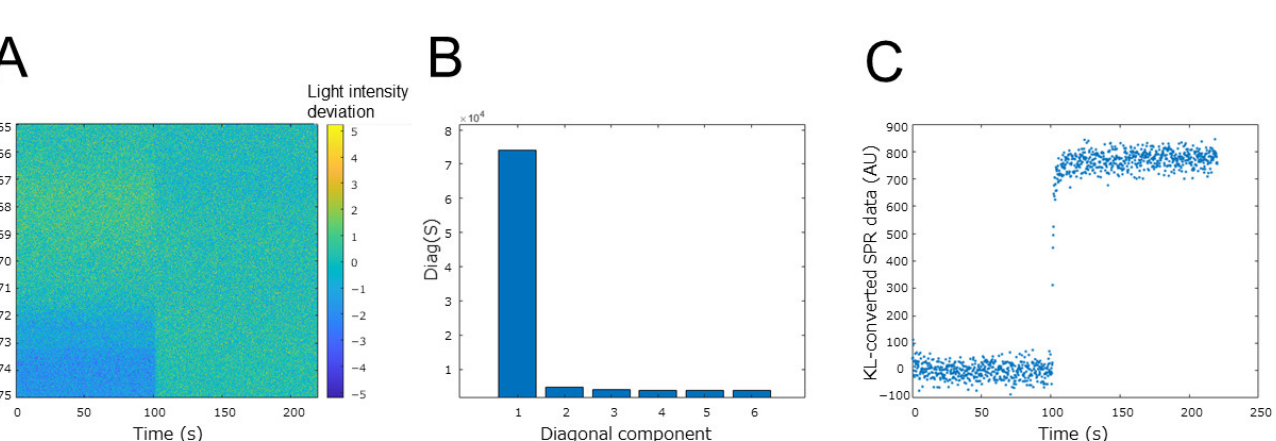
Figure 6. Change in KL-converted SPR curve data when sweeping the potential. ( A ) KL-converted SPR curve data. KL-converted SPR data value was normalized using the 0.5 V value and 0.25 V value. ( B ) Current change detected by potentiostat. ( C ) Electronic sweep.